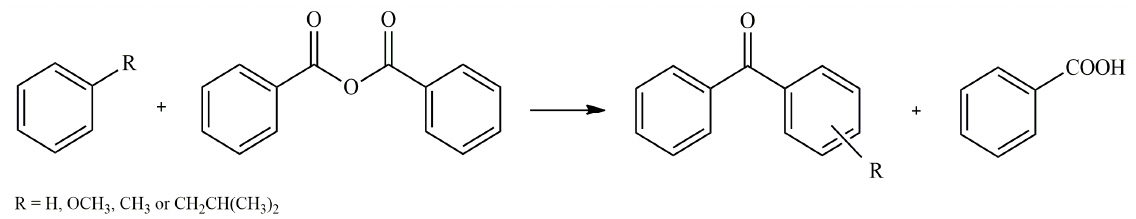
Figure 5. Benzoylation of methoxybenzene by benzoic anhydride.